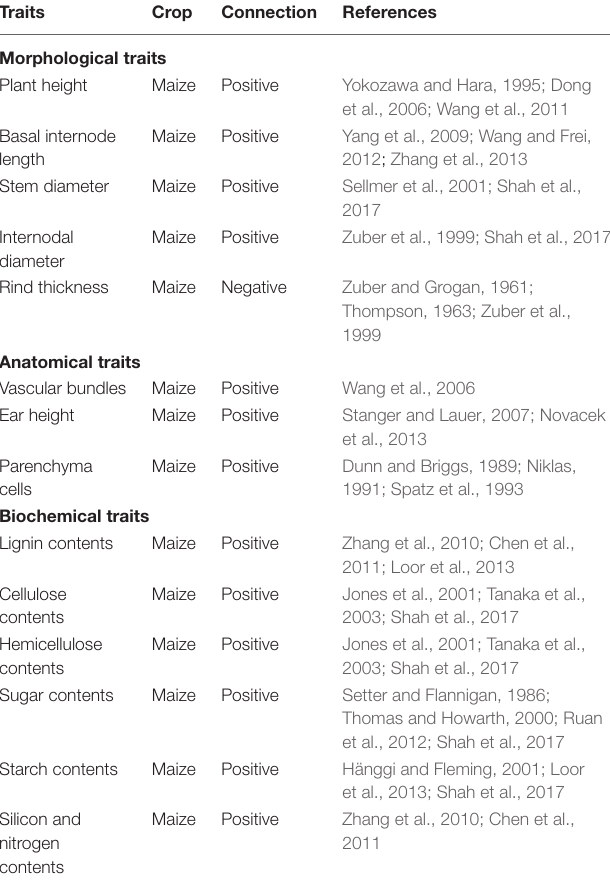
TABLE 1 | Plant traits of maize connected with stem lodging resistance and kernel abortion. Traits Crop